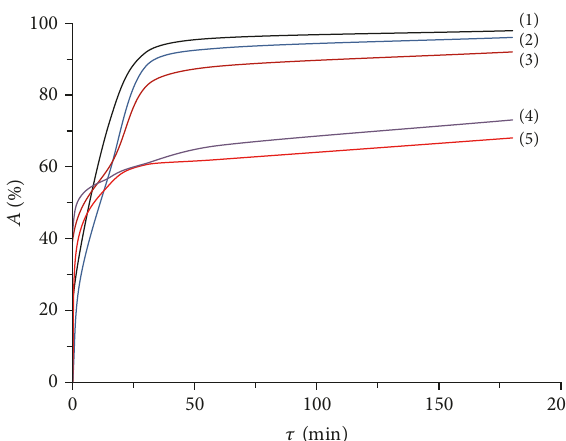
Figure 4: Kinetic curves of polymerization of MMA compositions depending on the nature and conditions of PM synthesis: (1) , (2) , (4) PVP-gr-PMMA; (3) PVP-gr-PS; (5) PMMA. The ratio of MMA: PVP in the synthesis of PM, mole/mole monomer concen- tration: (1) – (3) 3:1; (4) 1:1. Td. PM, K: (1) , (3) , (5) 313; (2) , (4)